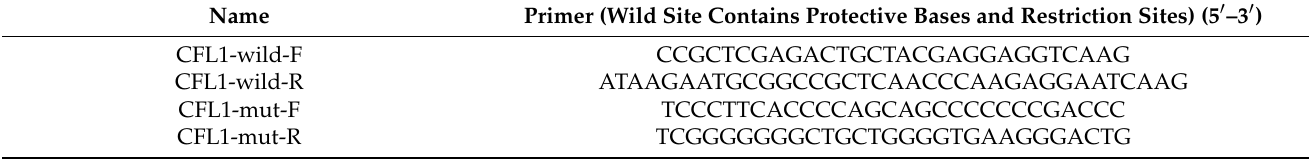
Table 2. Primer information for dual luciferase report